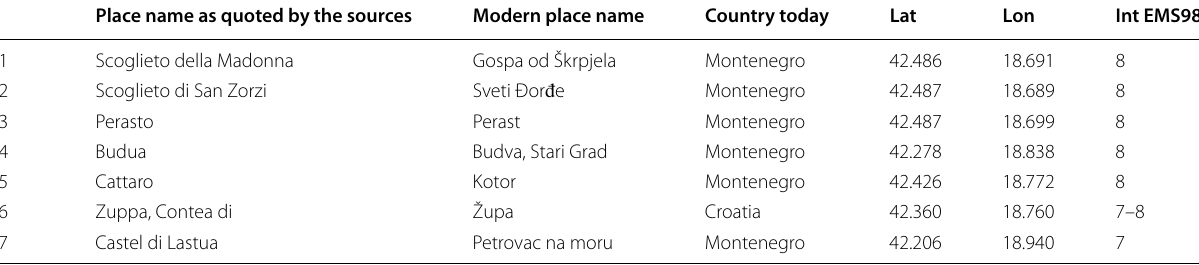
Table 4 Affected places in the Republic of Venice Place name as quoted by the sources